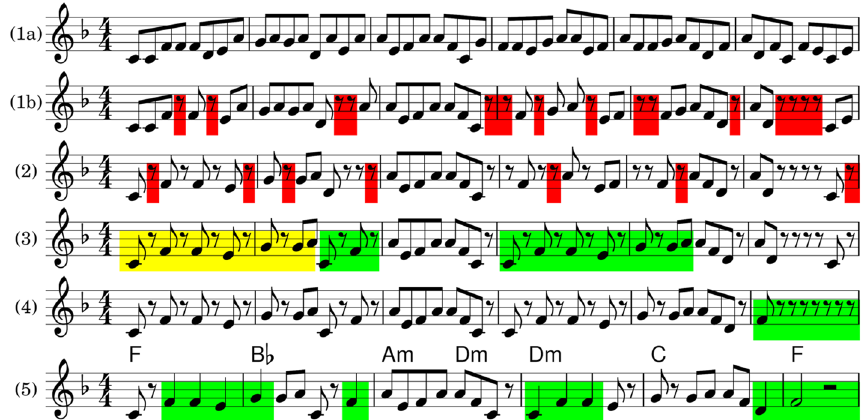
Fig. 2 Step-wise construction of a melody. Red areas mark note removals, yellow areas are notes to copy, and green areas mark